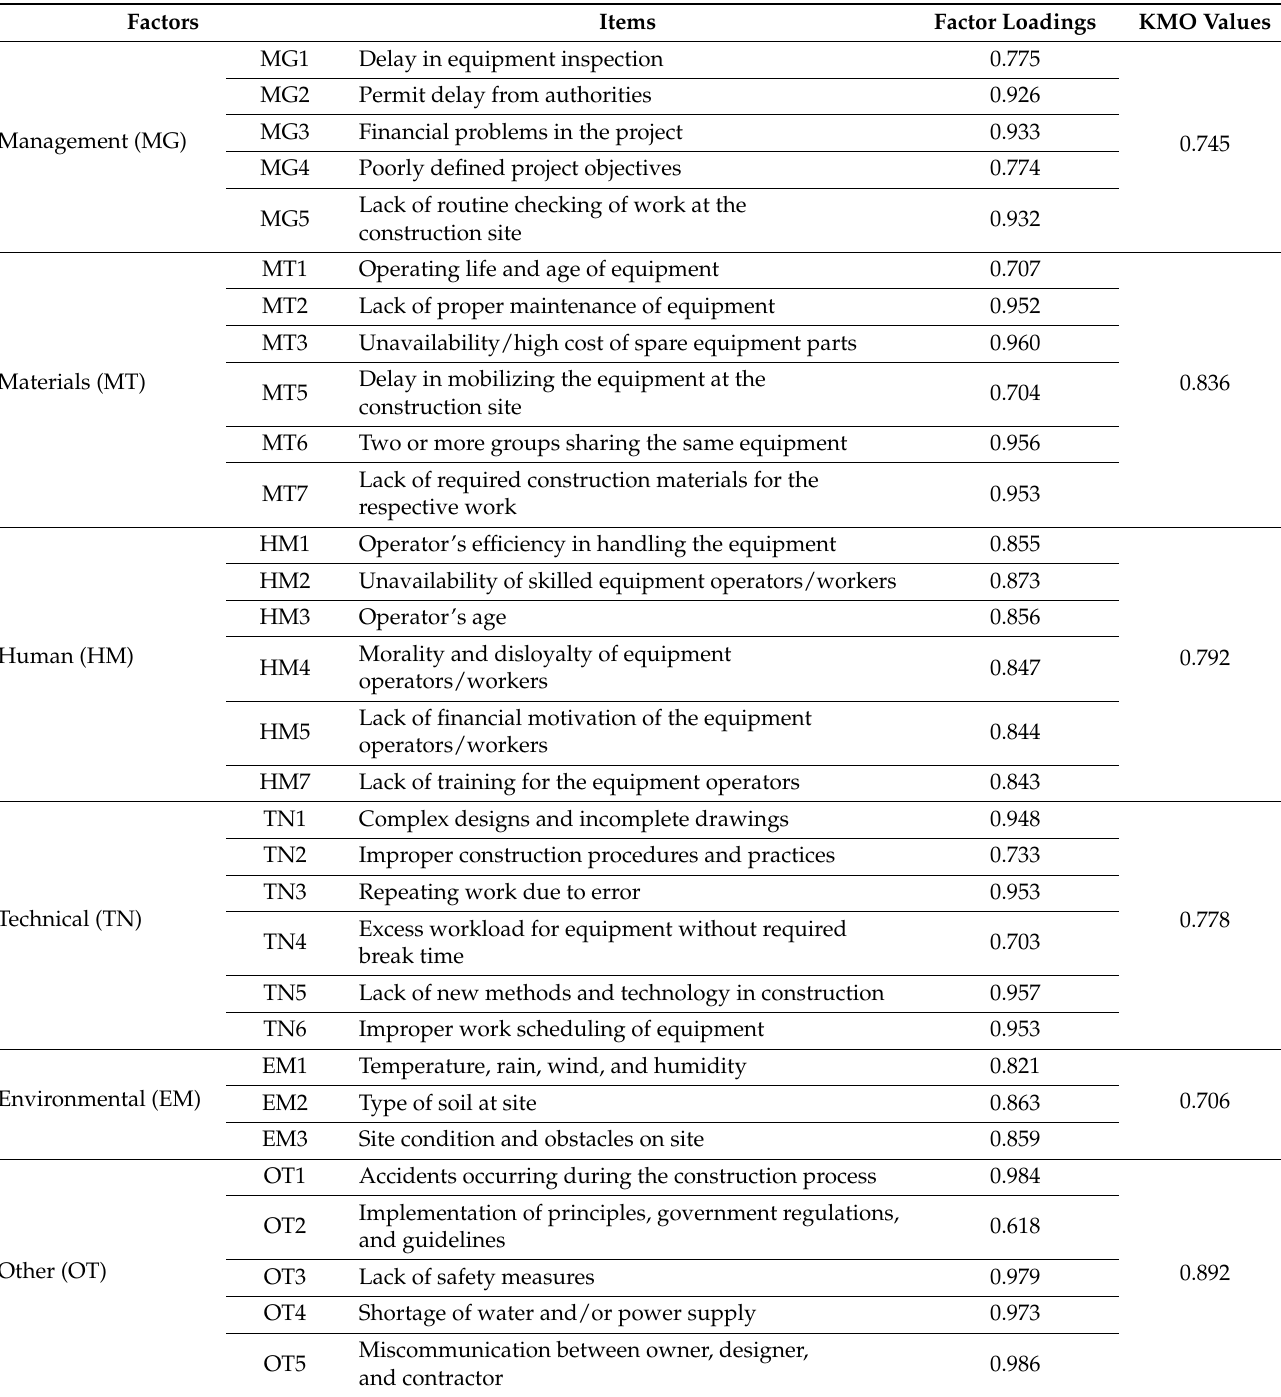
Table 3. Factor loadings and KMO values extracted from the